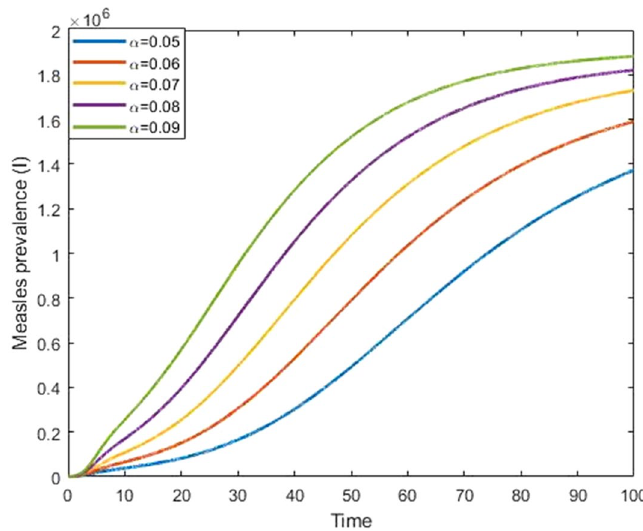
Figure 9. Impact of progression rate ( α ) on measles prevalence.